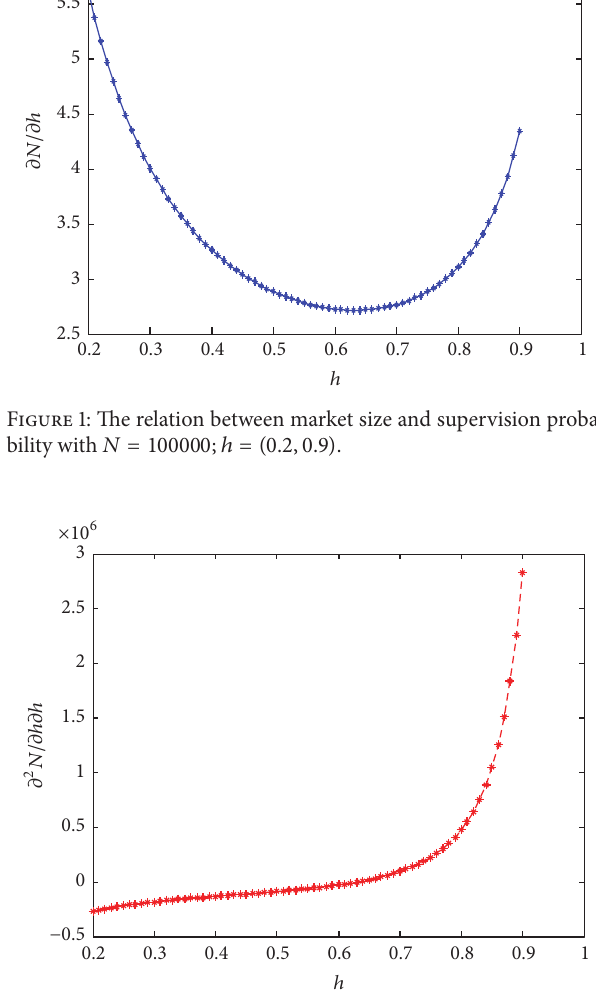
Figure 2: The change rate for the relation between market size and supervision probability with 𝑁 = 100000 , ℎ = (0.2,0.9)